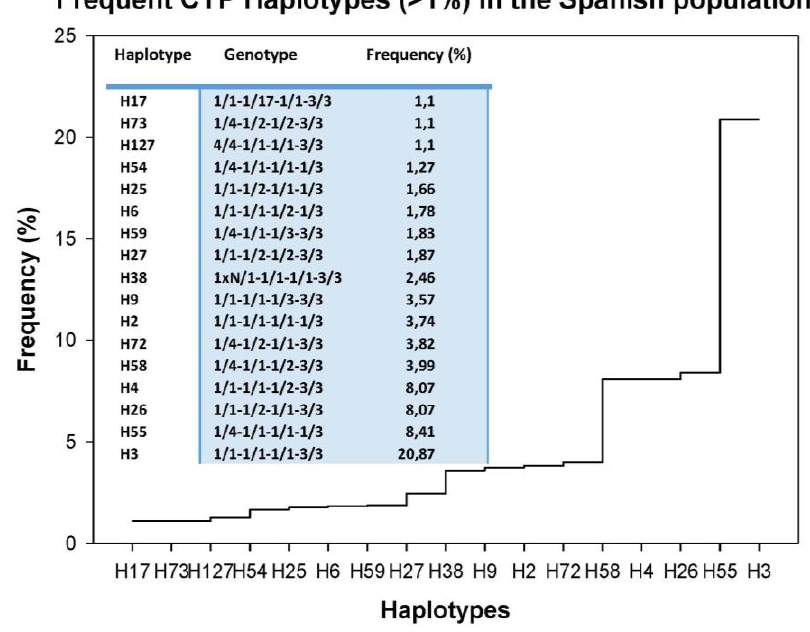
Figure 2. Frequent tetragenic CYP2D6-CYP2C19-CYP2C9-CYP3A4/5 haplotypes (>1%) in the Spanish population.